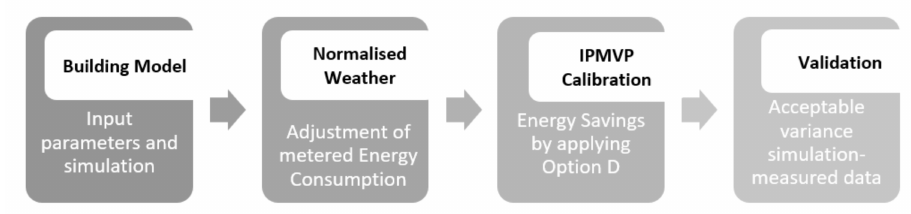
Figure 1. Outline of the model calibration